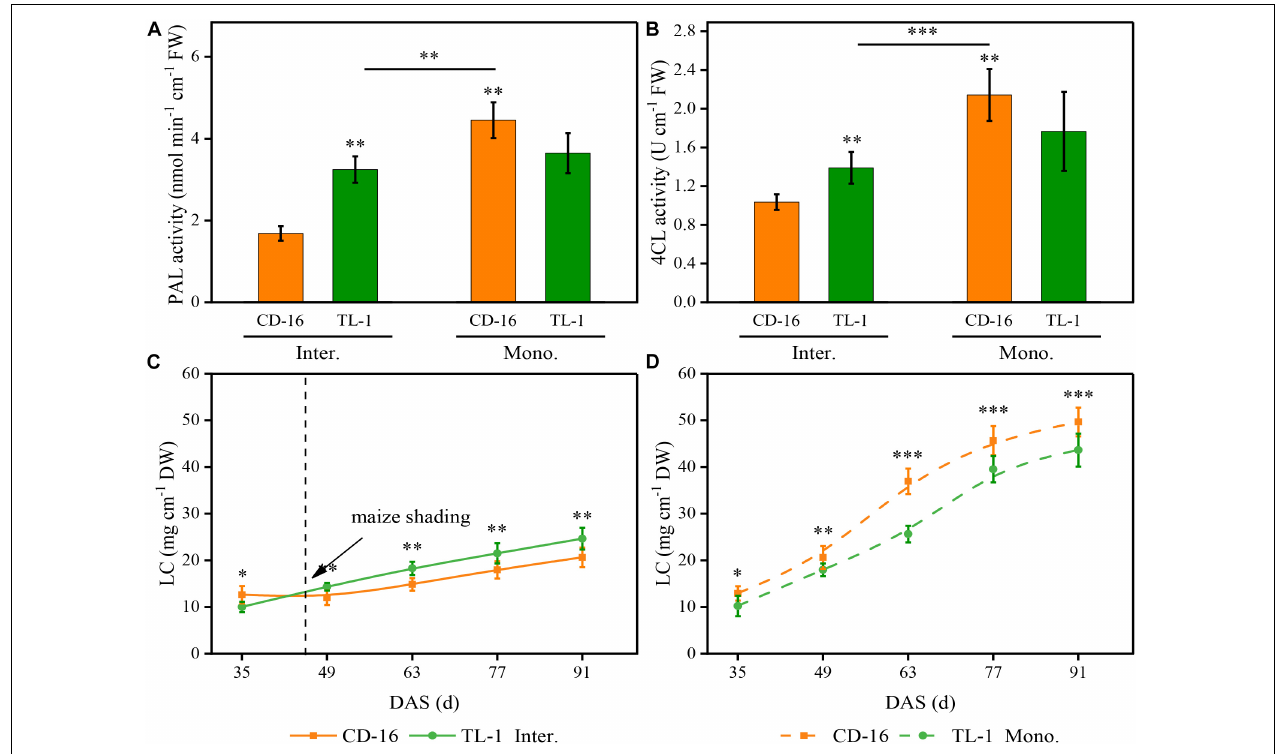
FIGURE 8 | Effects of different cultivars and planting patterns on PAL (A) , 4CL (B) , and LC (C,D) . The ∗ , ∗∗ , and ∗∗∗ Proportion of mixed chemical reagents indicate significant differences between CD-16 and TL-1 at the levels of p < 0.05, p < 0.01, and p < 0.001, respectively. The ∗∗ and ∗∗∗ on the black short line indicate significant differences between intercropping and monocropping at the levels of p < 0.005 and p < 0.001, respectively. The vertical black dotted line indicates that the maize begins to shade the intercropping soybean at this time. Data are average of three replicates. Error bars represent standard errors. The solid line and dashed line indicate strip intercropping and monoculture, respectively. Mono. and Inter. are the abbreviation of monoculture and strip intercropping, respectively. DAS represents the number of days after sowing.